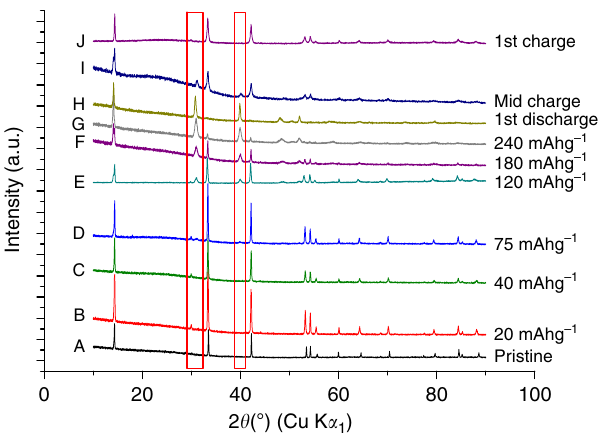
Figure 5 | Powder X-ray diffraction patterns of Li(V 0.5 Ti 0.5 )S 2 at various states of intercalation and deintercalation. Letters correspond to points on the 1st cycle in Fig. 3. Highlighted regions show the presence of Li 2 (V 0.5 Ti 0.5 )S 2 phase.